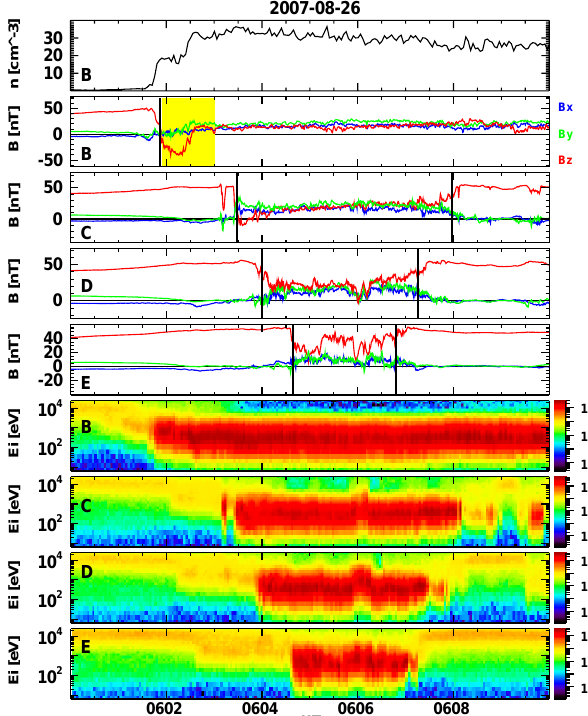
Fig. 5. The density, n from THB, the magnetic field (in GSM) and ion energy spectra measured by THB, THC, THD and THE through the event 1, i.e., from 06:00 to 06:10UT. The vertical bars indicate estimated magnetopause crossings. The yellow area marks an inter- val of the discussed change of the B Z magnetosheath magnetic field